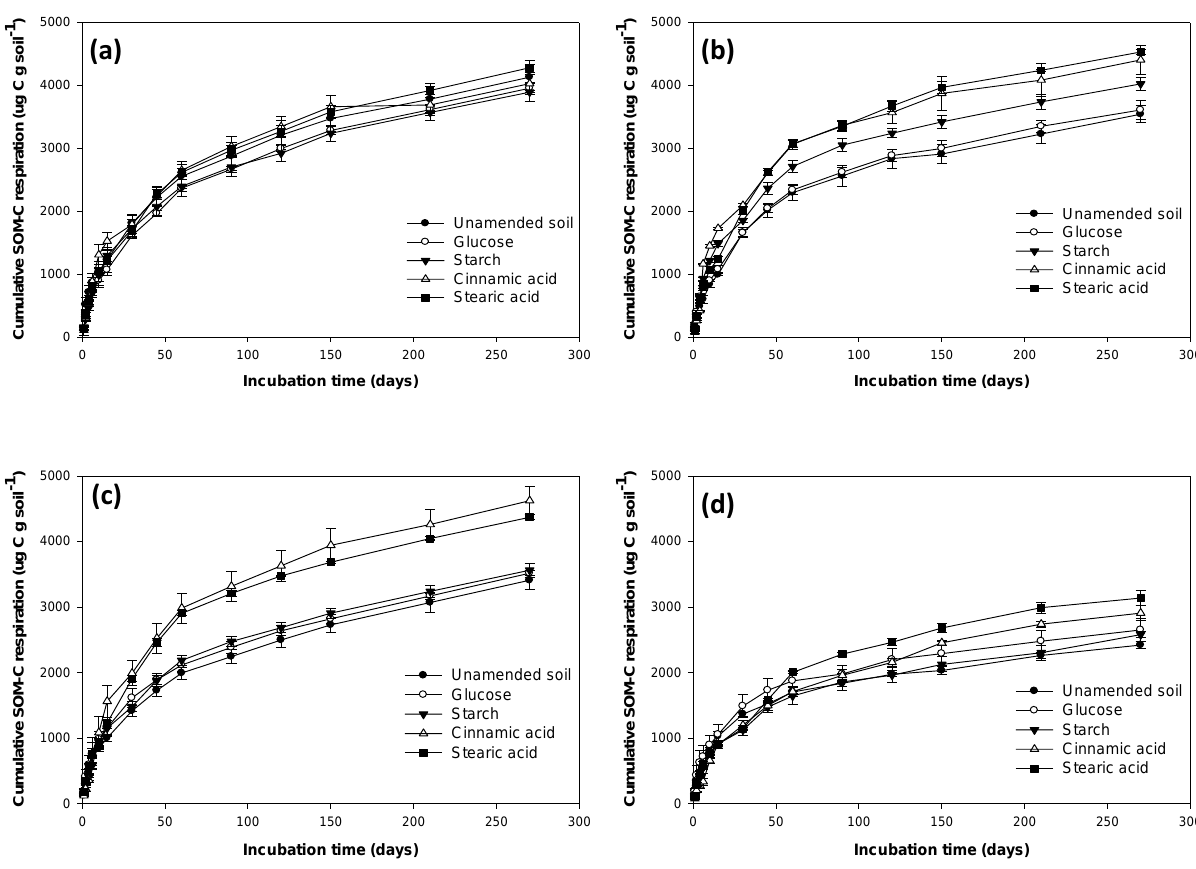
Figure 2. Soil organic carbon respiration in response to the addition of four C substrates in Mollisol (a) , Ultisol (b) , Andisol (c) , and Gelisol (d) . Symbols represent cumulative soil organic carbon respired as CO 2 in each sampling time along with standard error bar ( n =